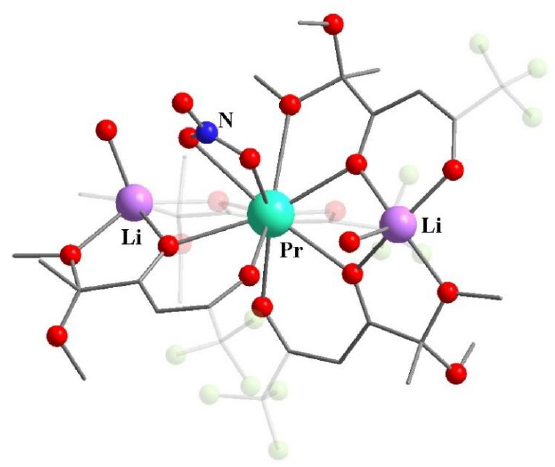
Scheme 14. Synthesis of discrete [Tb-Li] diketonate 39 .